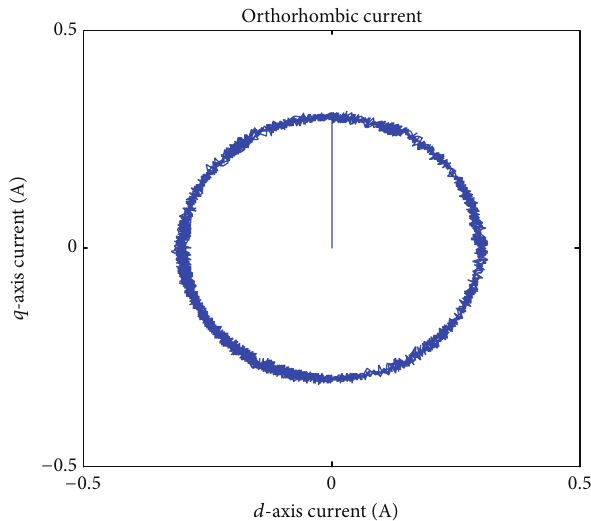
Figure 5: Stable case of induction currents in 𝑑 and 𝑞 directions.